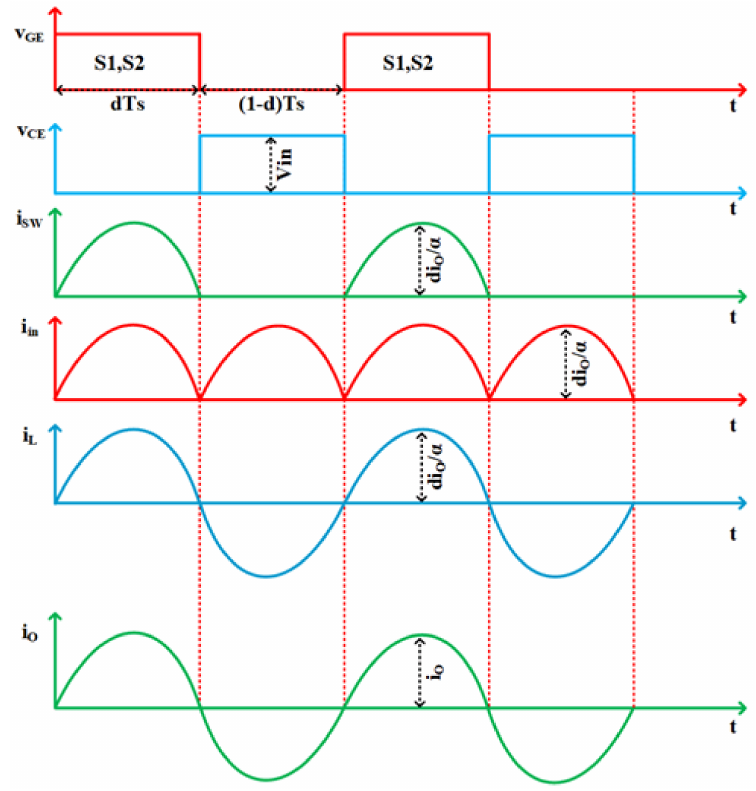
Figure 5. Operational waveforms of the proposed